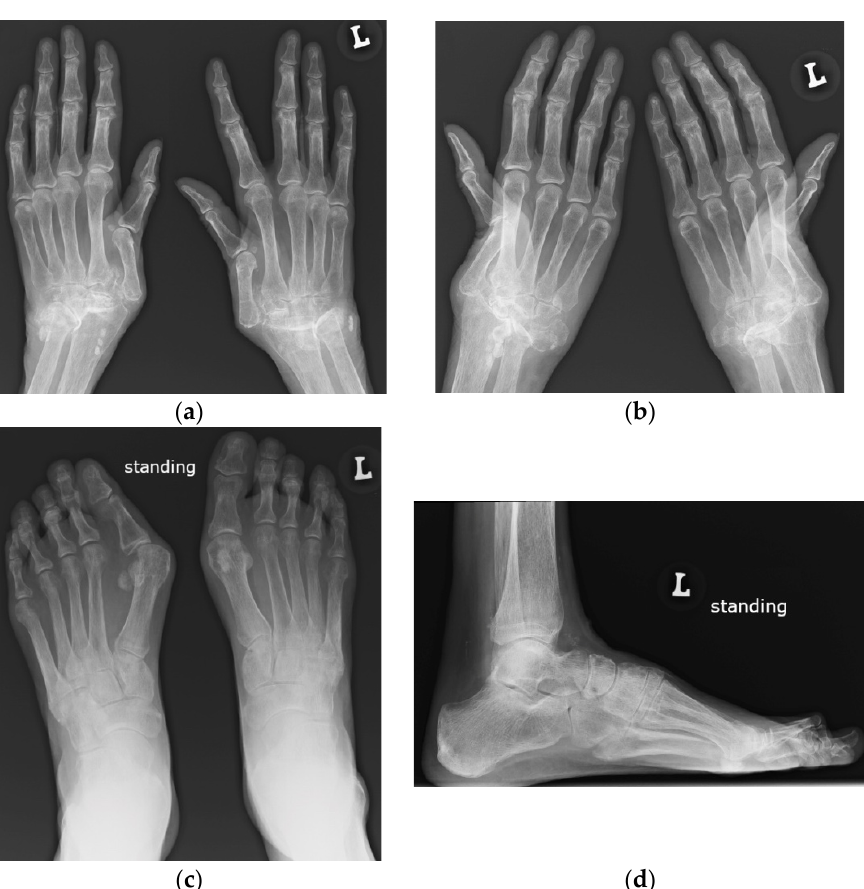
Figure 4. A 64-year-old female with SLE diagnosed in 1980 with Jaccoud’s arthropathy for hands and feet. ( a ) Posterior–anterior and ( b ) oblique radiographs of the hands show bone demineralization; soft tissue swelling at the wrists; periarticular calcifications; malalignment at the distal radioulnar, radiocarpal, and midcarpal joints; dislocation of the 1st carpometacarpal and subluxation of the 1st metacarpophalangeal joints; and joint space narrowing with cyst-like and erosive/destructive changes consistent with rhupus syndrome. Note the reversible contractures at the proximal interphalangeal joints, apparent in ( b ) and resolved or less apparent in ( a ). ( c ) Anterior–posterior standing radiograph of the bilateral feet and ( d ) lateral standing radiograph of the left foot show bone demineralization, bilateral hallux valgus deformities, and bilateral 2nd and 3rd hammer toes, as well as a right foot with moderate lateral subluxation. Table 2. Imaging findings in three types of systemic lupus erythematosus on radiographs, ultrasound, and magnetic resonance imaging.